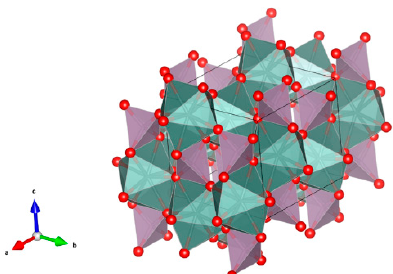
Figure 24. Xenotime (YPO 4 ). Ce,La,Nd,Th)(PO 4 ,SiO 4 ). Structure tetragonal, Sp. gr. I41/amd.